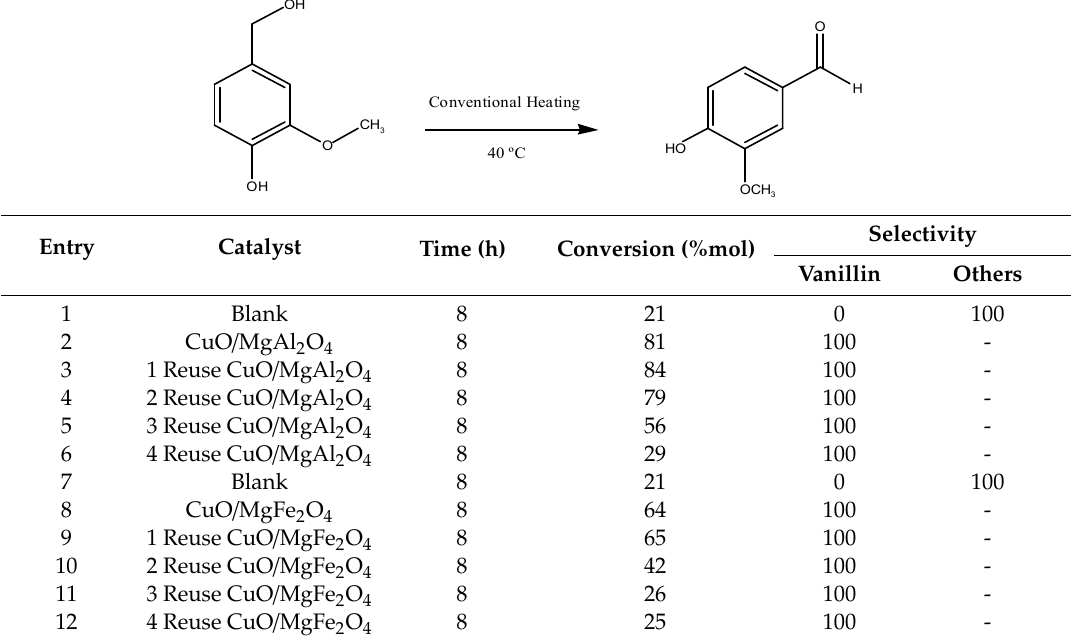
Table 4. Catalytic activity of CuO/MgAl 2 O 4 and CuO/MgFe 2 O 4 catalysts in the oxidation of vanillin alcohol to vanillin.